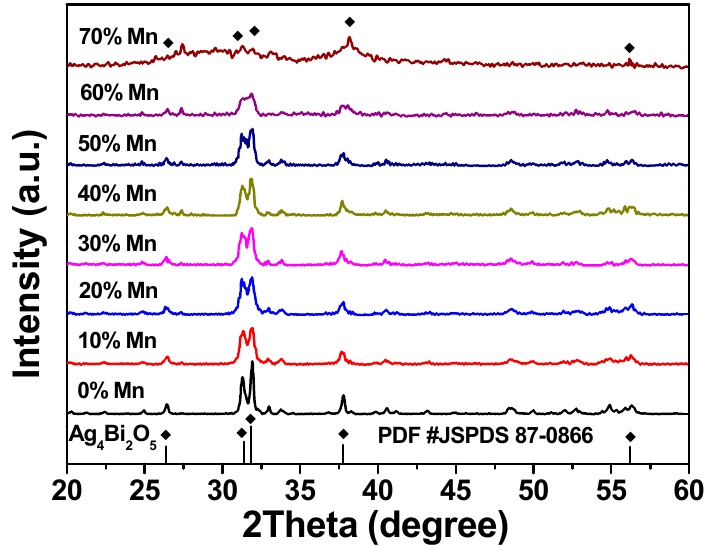
Figure 2. X-ray powder diffraction (XRD) patterns of Ag 4 Bi 2 O 5 /MnO 2 with different ratios of manganese dioxide contents from 0% to 70%.